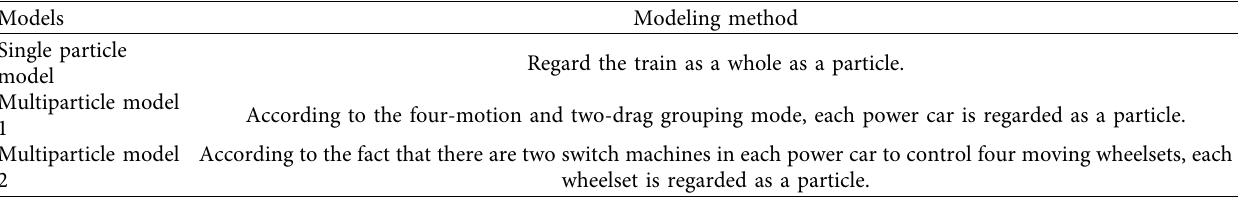
Figure 3: Finite element solution model. (a) Solid geometry diagram. (b) Overall meshing. (c) Local Table 1: Modeling methods of different models.